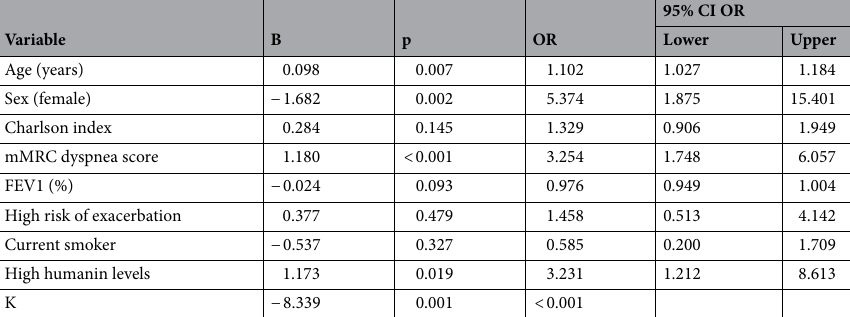
Table 3. Logistic regression analysis showing factor associated with walking less than 350 m in 6-min walk test (dependent variable). High humanin levels = humanin higher than median. High risk of exacerbation = 2 or more exacerbations during previous year or 1 previous admission. FEV1 = forced expiratory volume in the first second.